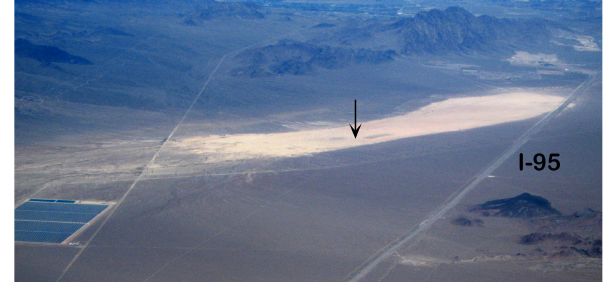
Fig. 4. The playa (about 6km long) seen from a commercial air- liner approaching Las Vegas. The approximate measurement site is arrowed. Highway I-95 runs roughly north–south. The blueish rect- angular feature at left is a solar power facility.